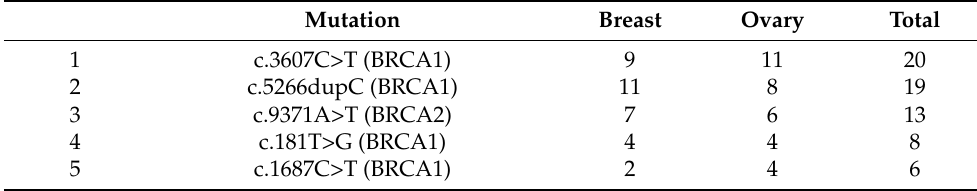
Table 9. The prevailing mutation variants